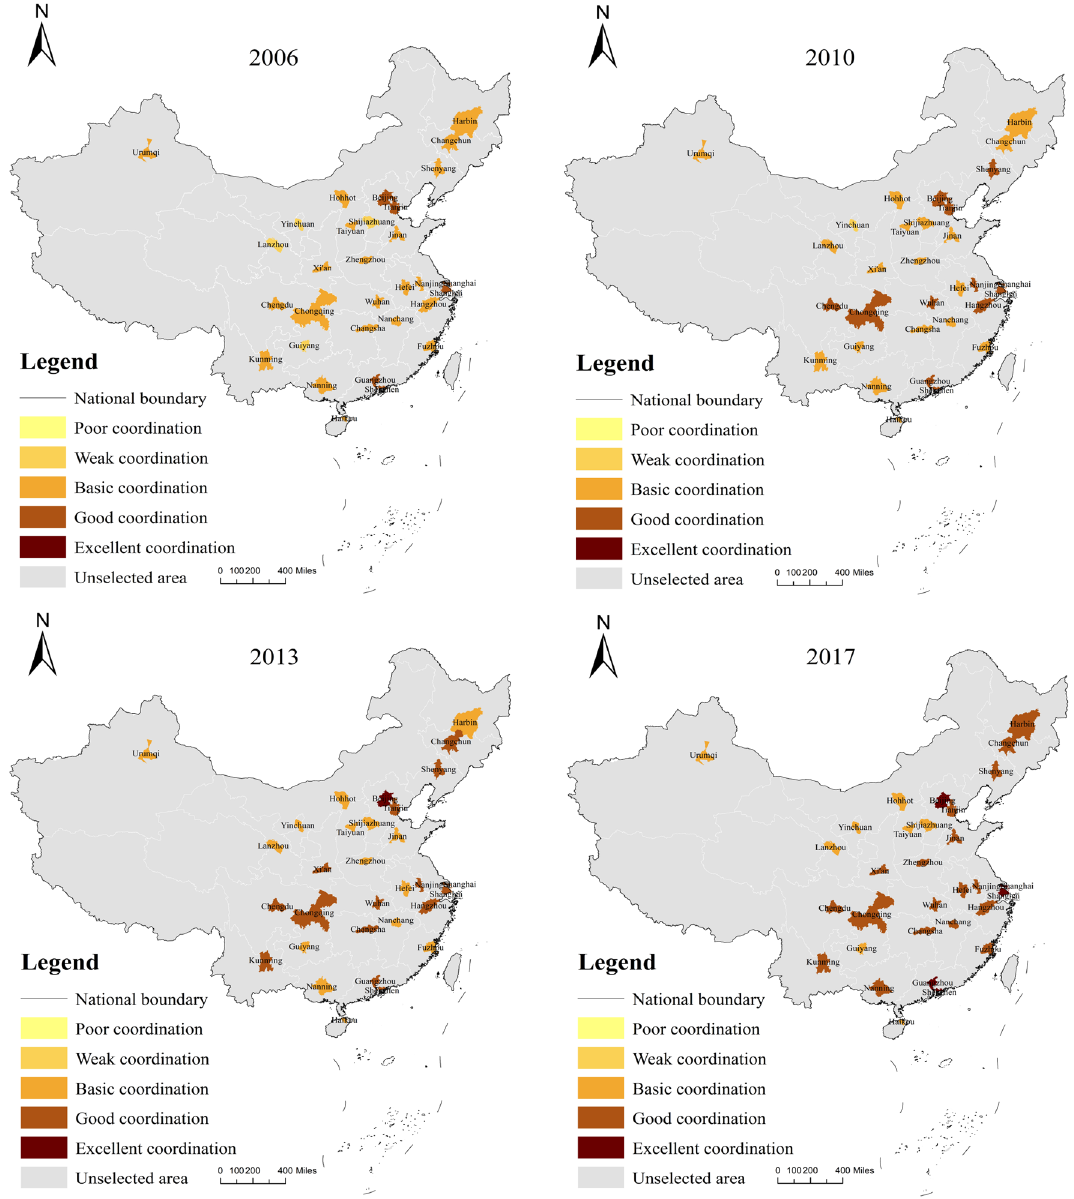
Figure 6. CCD of low-carbon-economic-environment